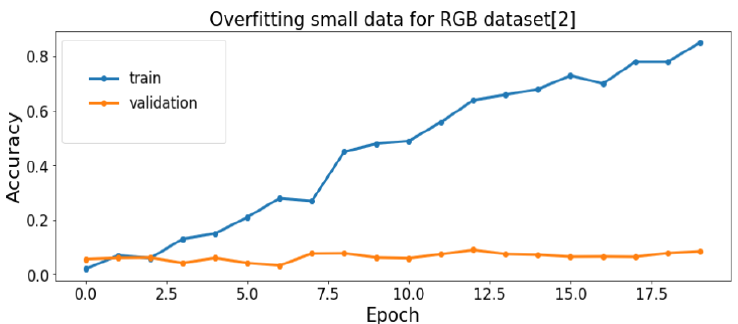
Figure 8. Overfitting small data for RGB dataset-2. Table 2. Comparison with other datasets for testing accuracy and calculation time.